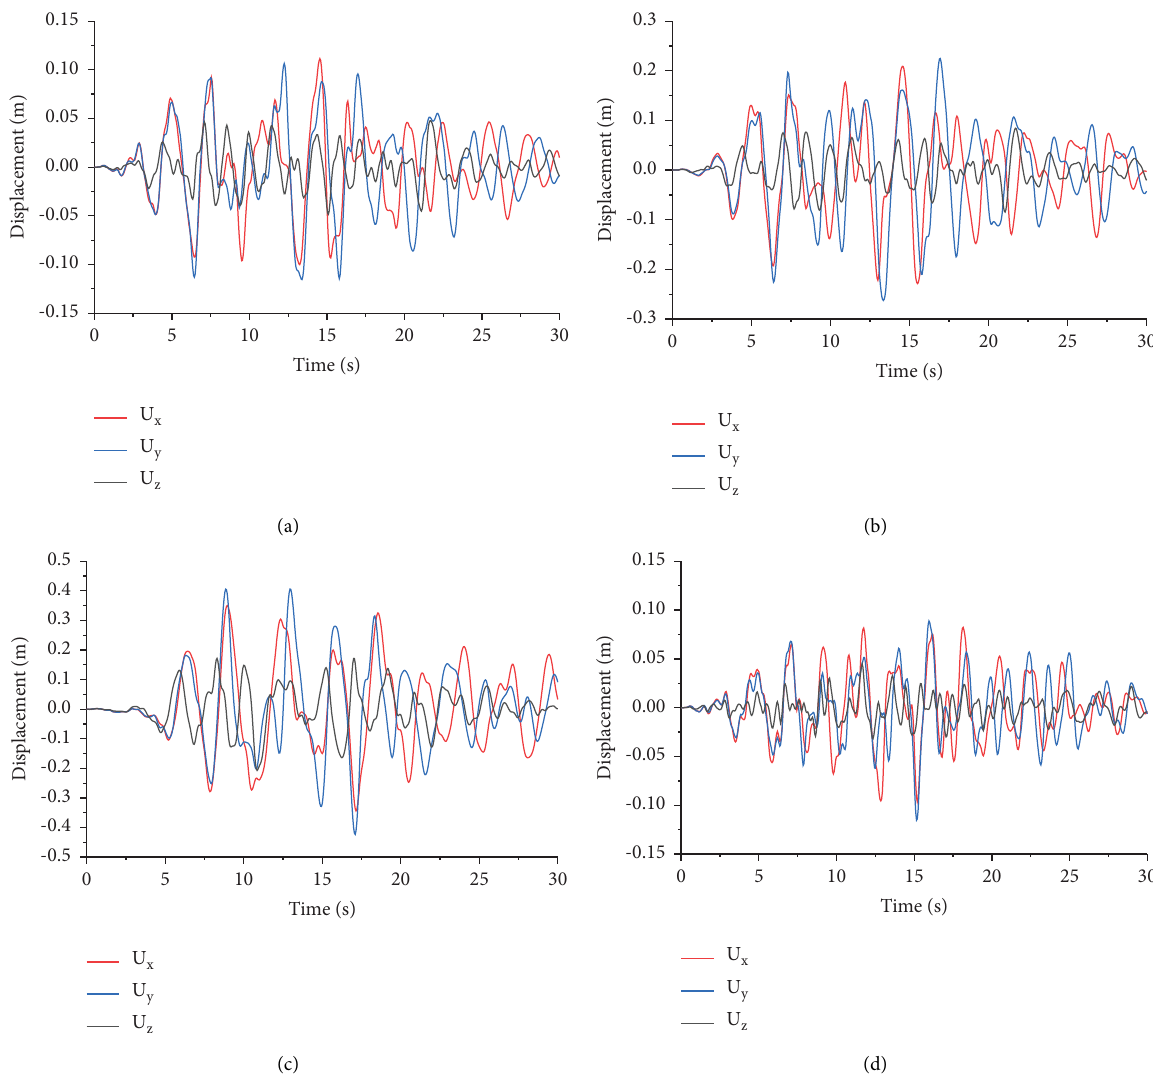
Figure 6: Displacement time-history curve. (a) Maximum buried depth (2,481.8 m). (b) Top of the maximum buried depth (4,435.9 m). (c) Highest altitude (5,265.8 m). (d) Valley (2,378.6